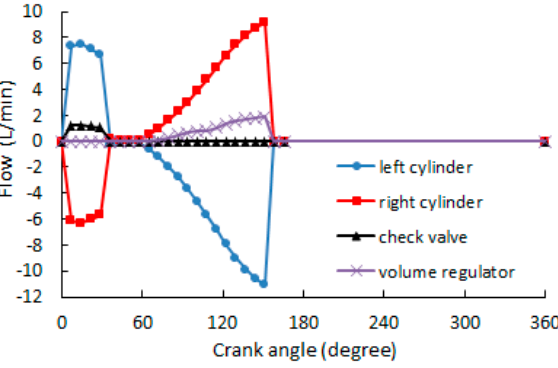
Figure 10. Flow of 1 mm adjustment at 800 r/min.